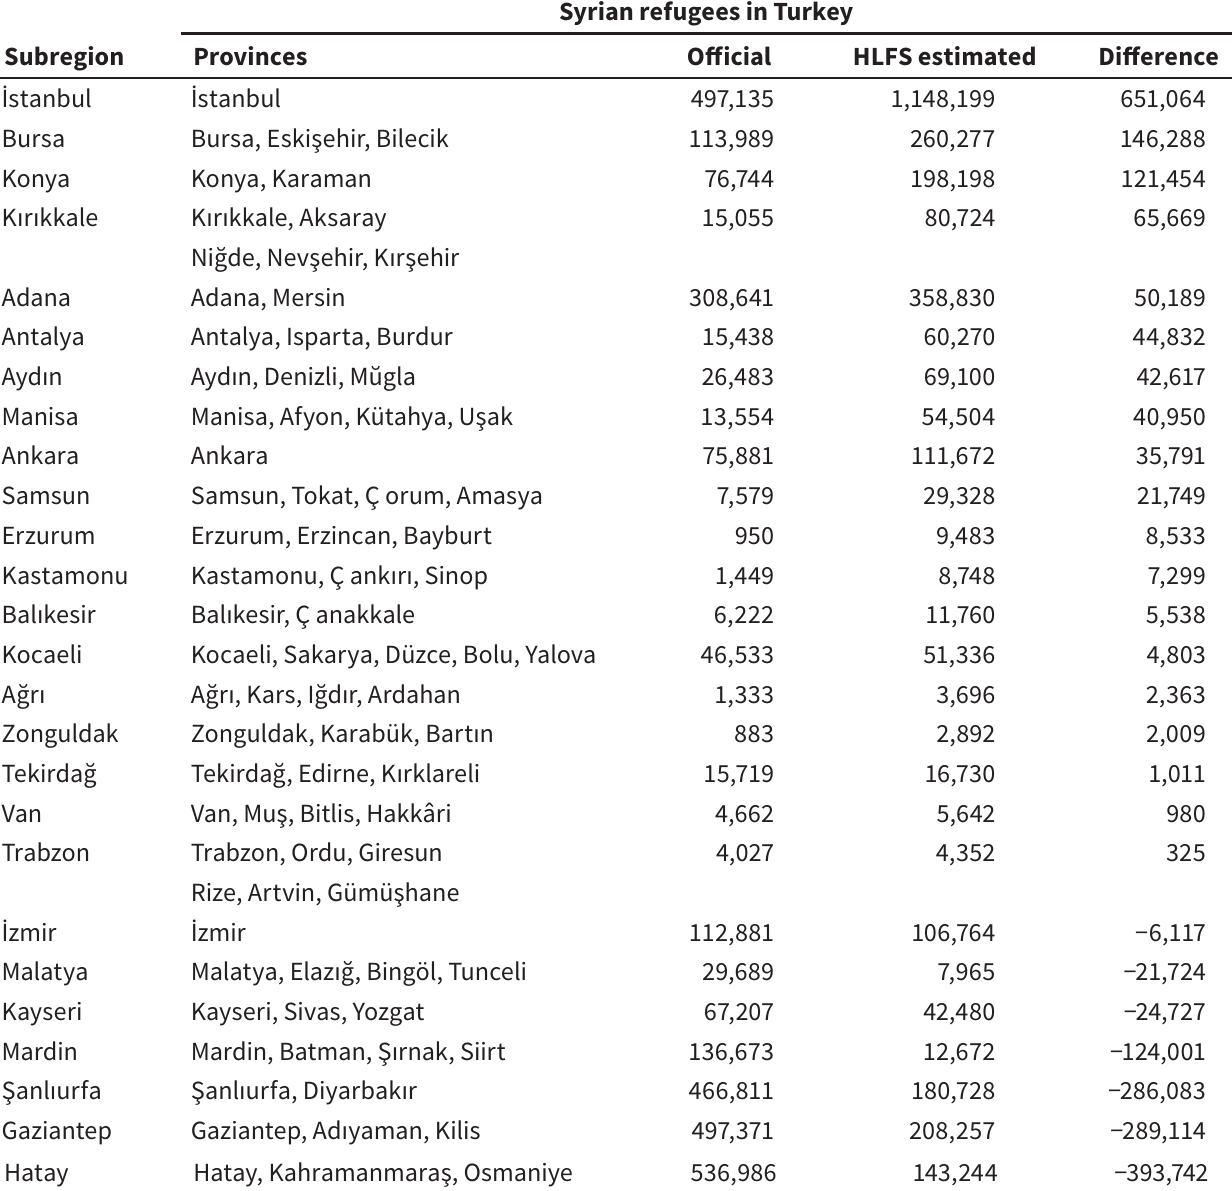
Syrian refugees under temporary protection in Turkey by subregion (NUTS-2),